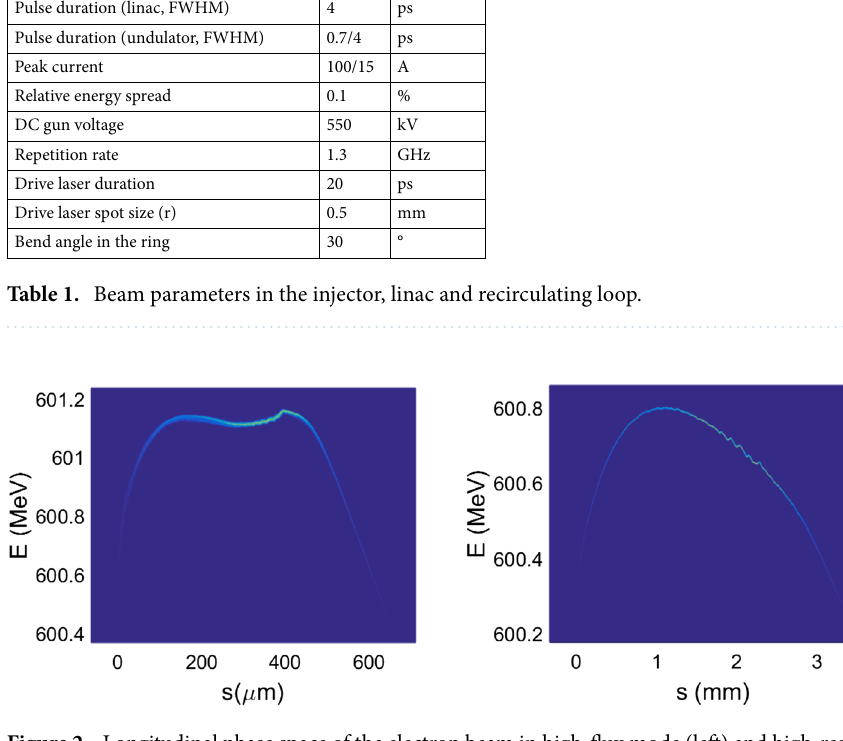
Figure 2. Longitudinal phase space of the electron beam in high-flux mode (left) and high-resolution mode (right) at the entrance of undulator.